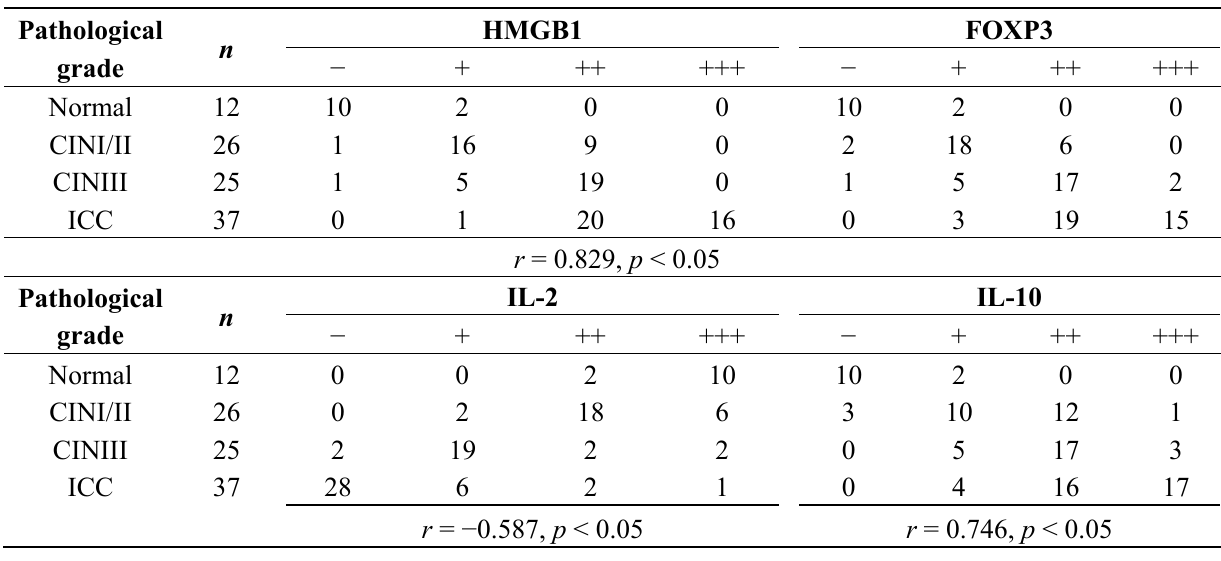
Table 3. Association between HMGB1 and FOXP3, IL-2, IL-10 expression in cervical